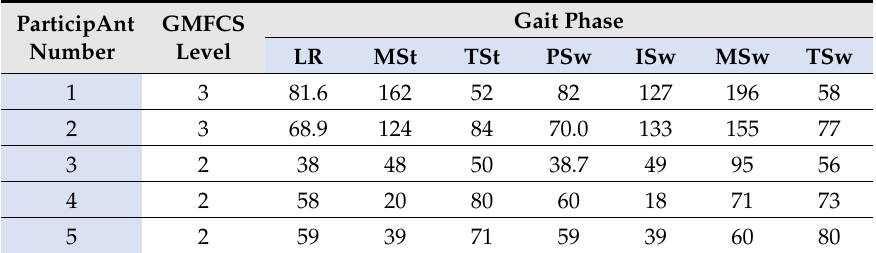
Table A1. Root mean square error (RMSE) of gait phase detection onset relative to motion capture for five children with cerebral palsy (CP). Gross motor function control system (GMFCS) is indicated. Gait phases are loading response (LR), mid-stance (MSt), terminal stance (TSt), pre-swing (PSw), initial swing (ISw), mid-swing (MSw) and terminal swing